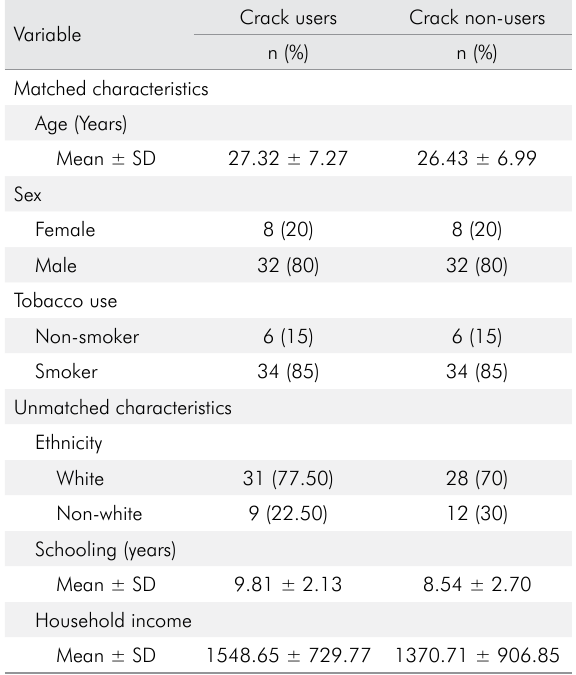
Table 1. Distribution of demographic variables of participants (n =